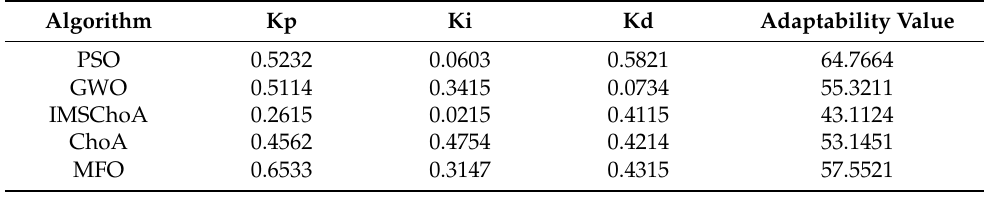
Table 6. Tuning parameters of PID controller optimized by different algorithms.